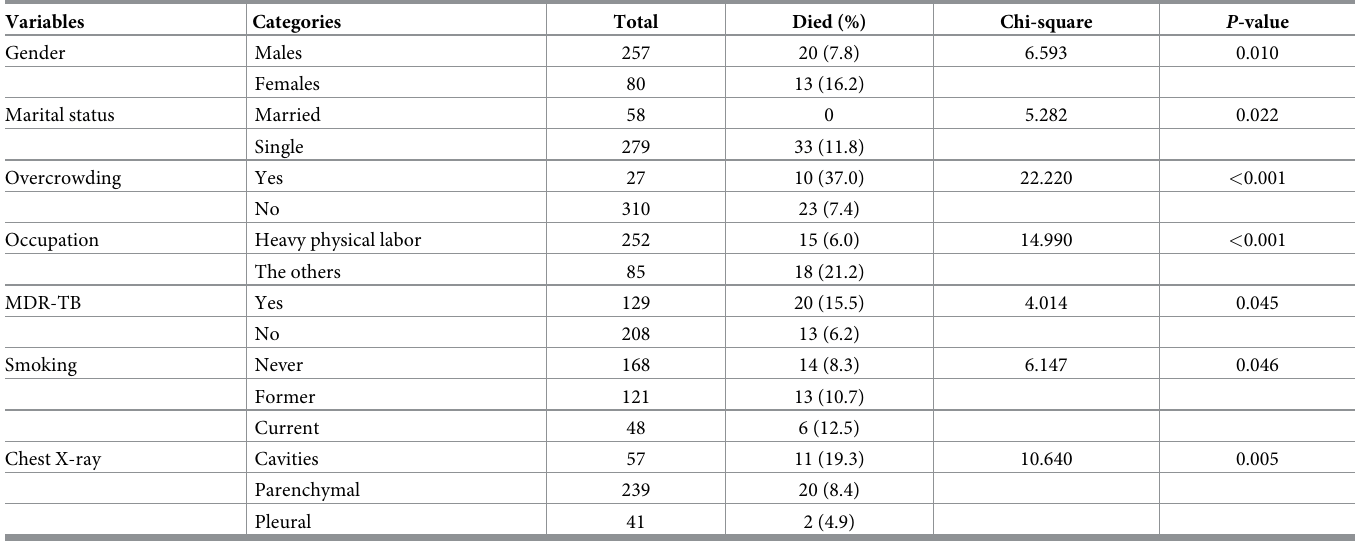
Table 3. The Log-rank test of factors influencing survival of TB patients in Liberian. (n = 337).